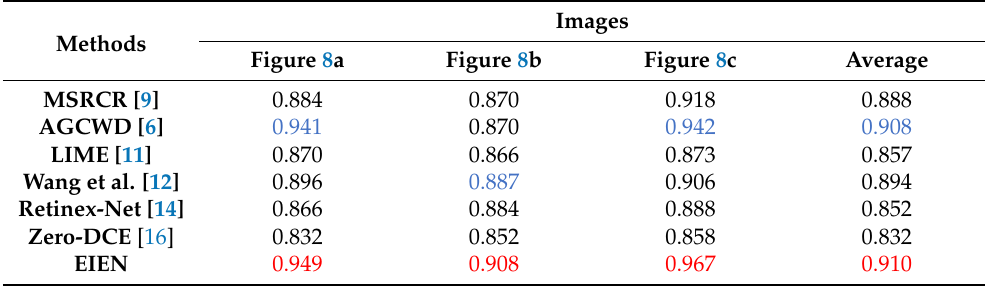
Table 2. SSIM results for different algorithms. The best result is in red whereas the second best one is in blue.